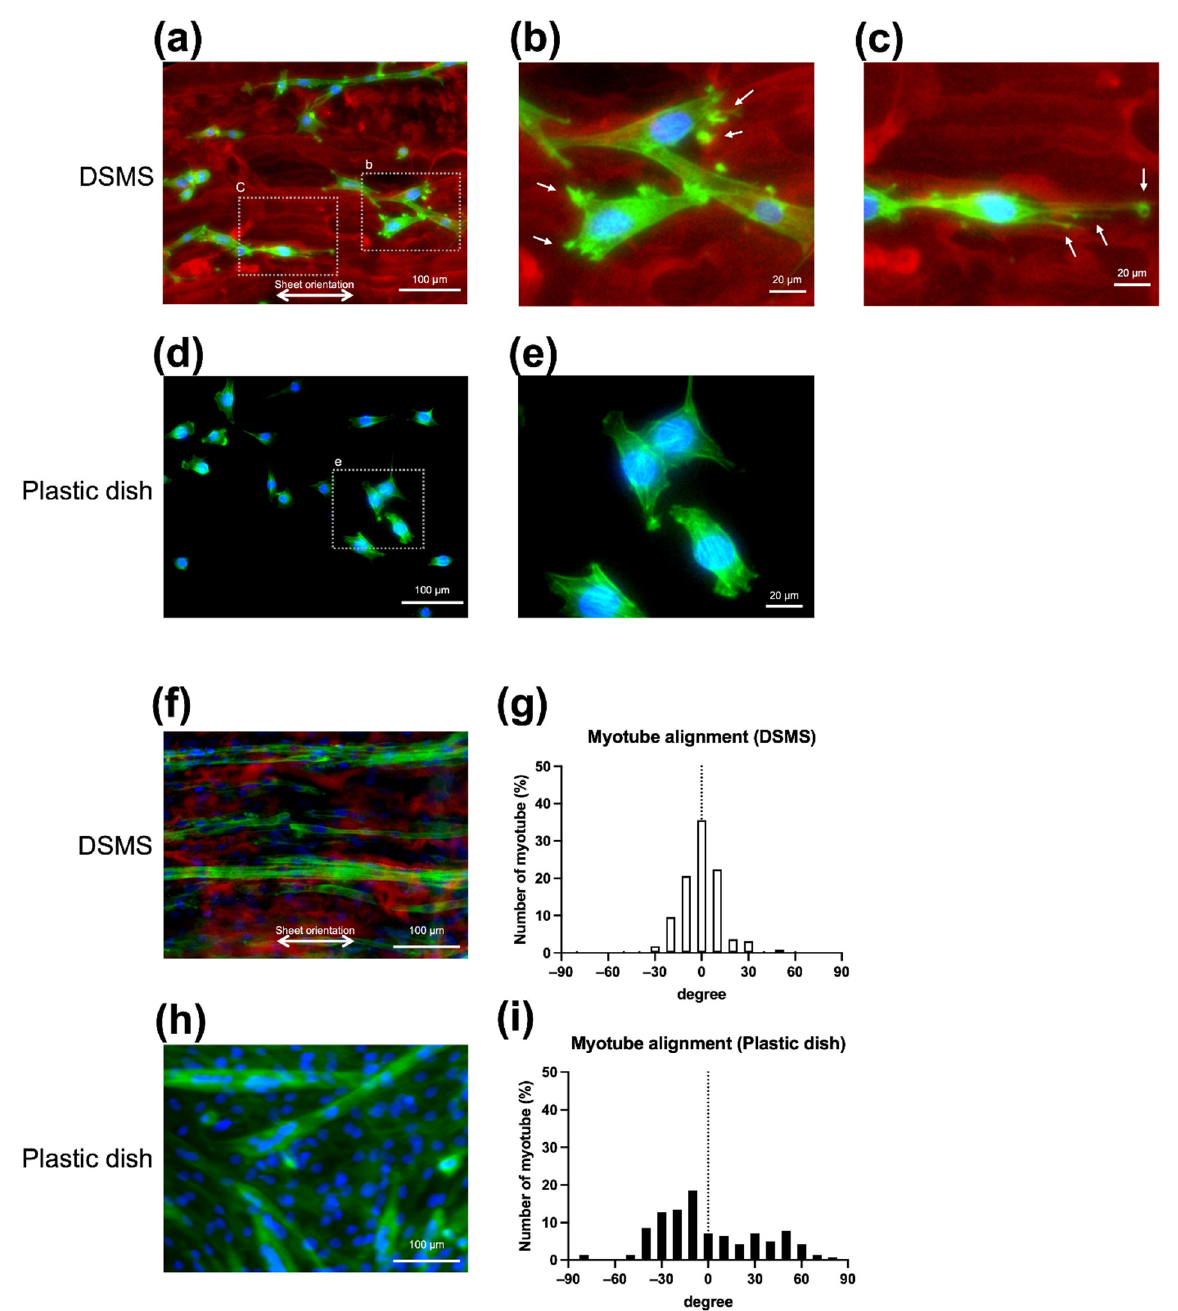
Figure 3. Comparison of myoblasts and morphology of myotubes. Green: phalloidin, red: COL IV, and blue: Hoechst 33342. ( a ) Myoblasts adhered to DSMS. Myoblasts aligned with the remaining COL IV in the DSMS; ( b ) Magnified image. Myoblasts on the DSMS developed actin spikes that appeared to be adhesion plaques (arrow); ( c ) Magnified image. Myoblasts on the DSMS developed lamellipodia and filipodia (arrow); ( d ) Myoblasts adhered to the plastic dish; ( e ) Magnified image. Myoblasts on the plastic dishes did not develop adhesive spots; ( f ) Myotube formation on DSMS. Myotubes formed along the extracellular matrix orientation in DSMS; ( g ) Histogram of angles in myotubes formed on the DSMS. Most myotubes were in the ± 20 ◦ range; ( h ) Myotube formation on the plastic plate. Myotubes on the plastic plate formed in random orientation; ( i ) Histogram of angles in myotubes formed on the plastic plate. Various angles of myotubes were present on the plastic plate. DSMS, decellularized skeletal muscle